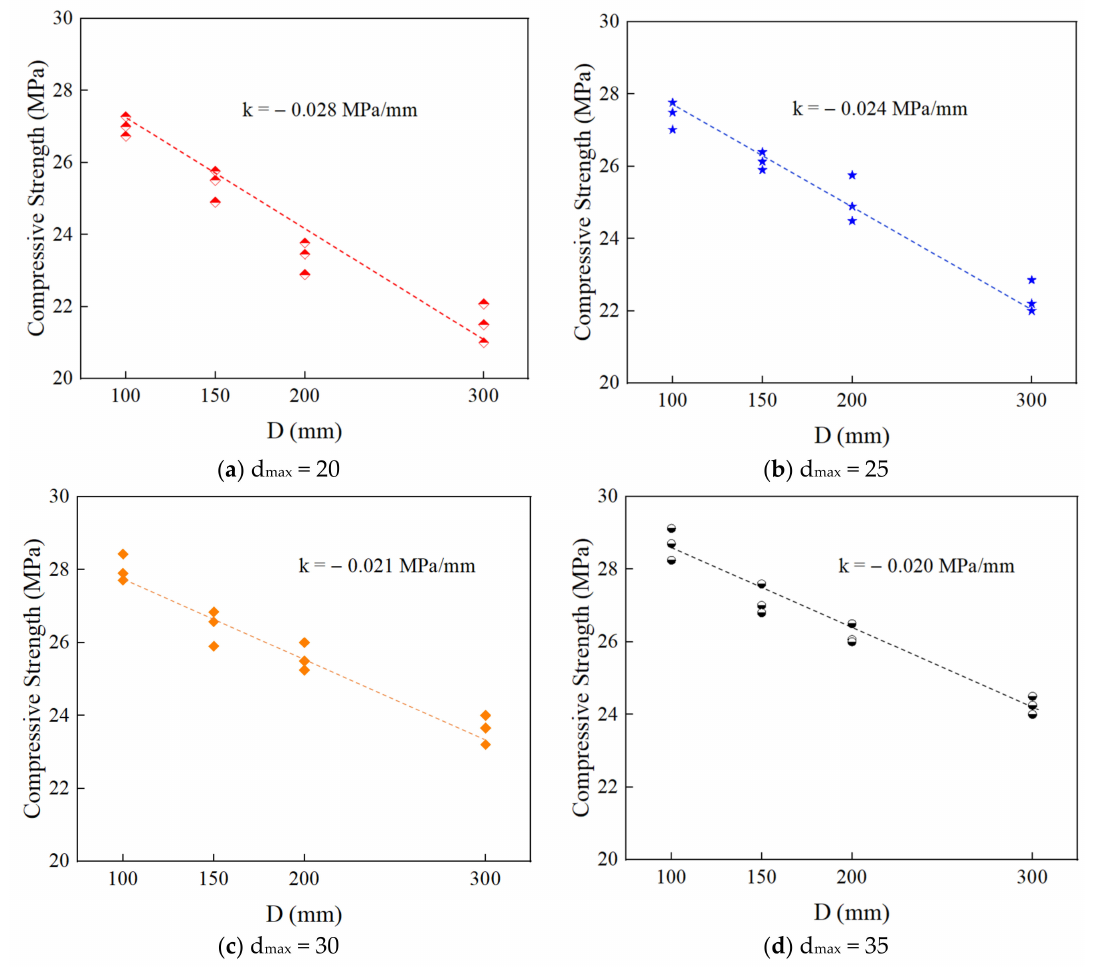
Figure 21. The relationship between the compressive strength and the specimen size of